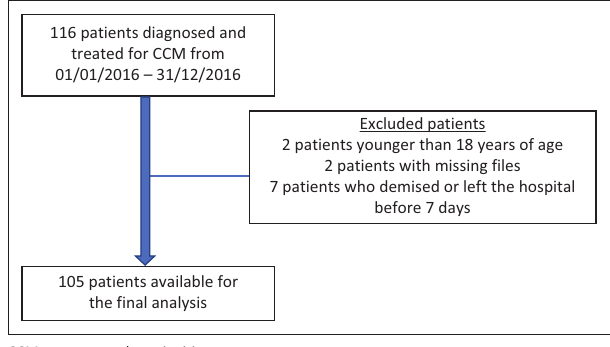
FIG URE 1: Flow diagram showing patients enrollment in the study.